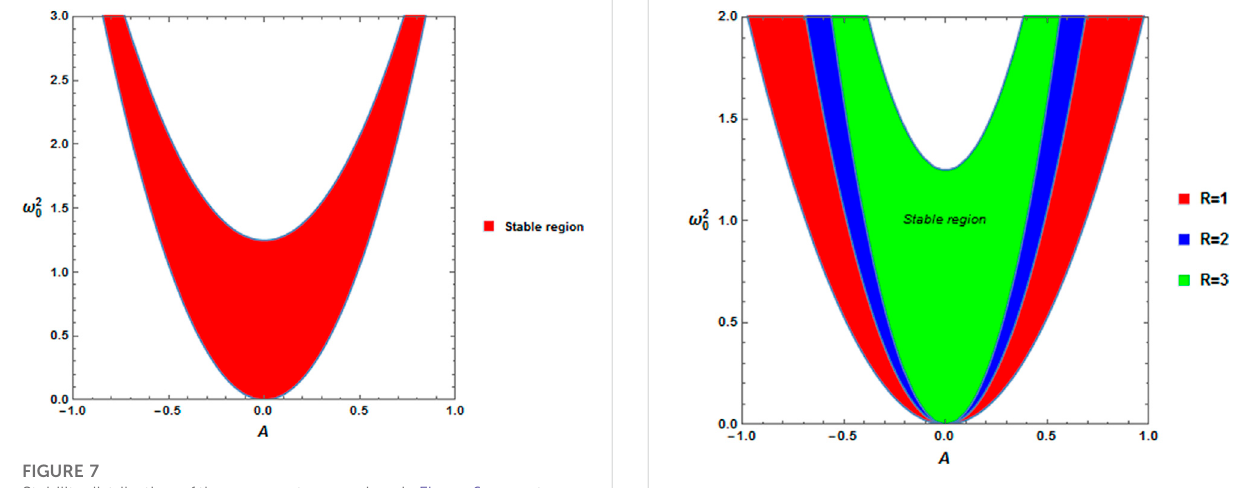
FIGURE 9 Stability distribution of the same system, as given in Figure 7, of P (cid:2) 0 . 2.